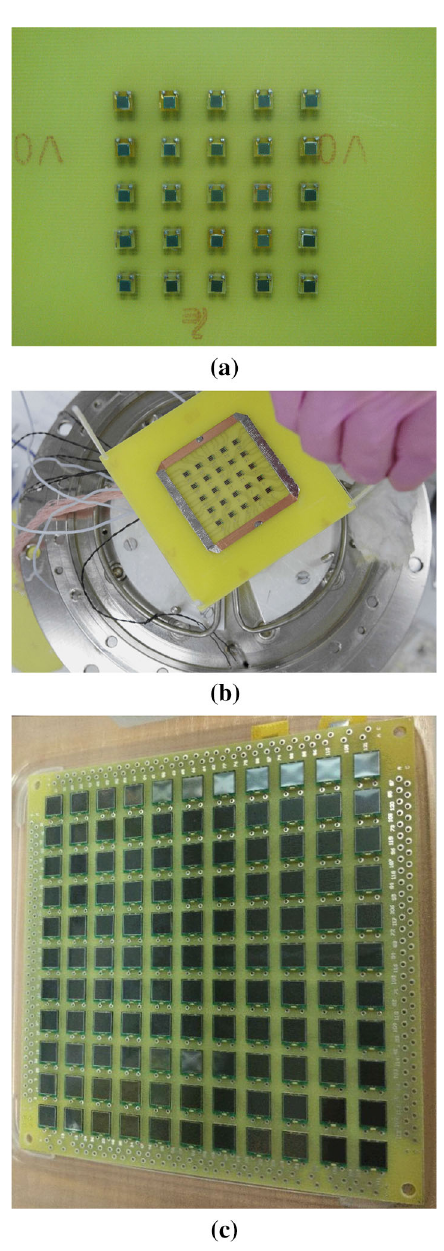
Fig. 5 Photographs of SiPM matrices progressively developed in this work. (a) 5 × 5 SiPM matrix made from MRS APD 149-35 (CPTA) with an active area of 2 . 1 × 2 . 1 mm 2 . (b) 5 × 5 SiPM matrix made from MPPCS10931-100P(Hamamatsu)withanactiveareaof3 × 3mm 2 . (c) 11 × 11 SiPM matrix made from MPPC S13360-6050PE (Hamamatsu) with an active area of 6 × 6 mm 2 . The SiPM channel pitch is 1 cm in all